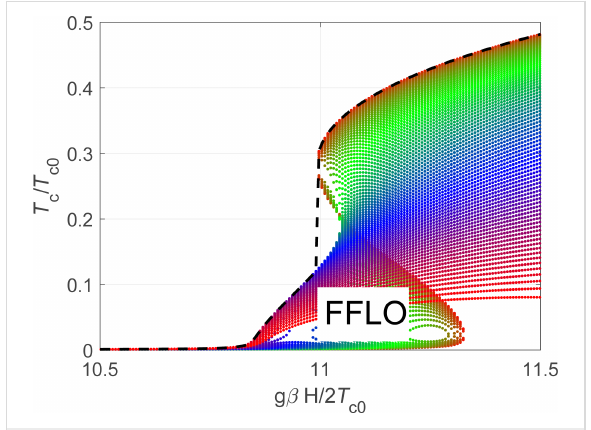
Figure 4: Critical temperature of the system as a function of the Zeeman field h for ε so = 0.46 T c0 , Γ s → 0 and Γ w = T c0 for the supercon- ducting states with different modulation vectors q ranging from q = 0.44 m s T c0 / k Fs at h = 11.05 T c0 to q = m s T c0 / k Fs at h = 10.8 T c0